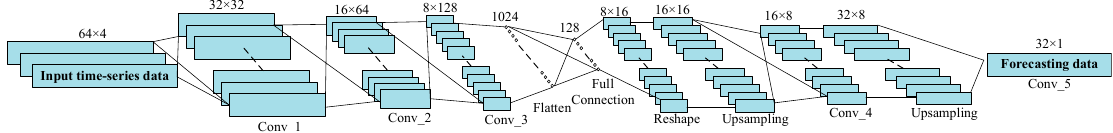
Figure 4. Structure of the CNN model adopted for forecasting.